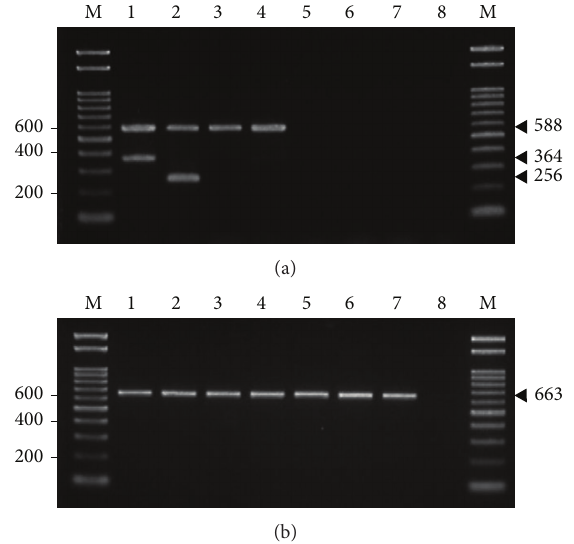
Figure 2: Agarose gel electrophoresis of the amplification specificity of optimized TMPCR (a) and 16S rDNA PCR (b), using represen- tative target and nontarget gDNAs. In lanes 1 to 8, amplification reactionscontained V.cholerae O1, V.cholerae O139, V.cholerae NAG I, V. cholerae NAG II, Vibrio parahaemolyticus , Vibrio vulnificus , Escherichia coli , and nuclease-free water, respectively. The expected sizes of specific amplicons (base pairs) were compared to the 100 bp standard ladder marker (lane M).